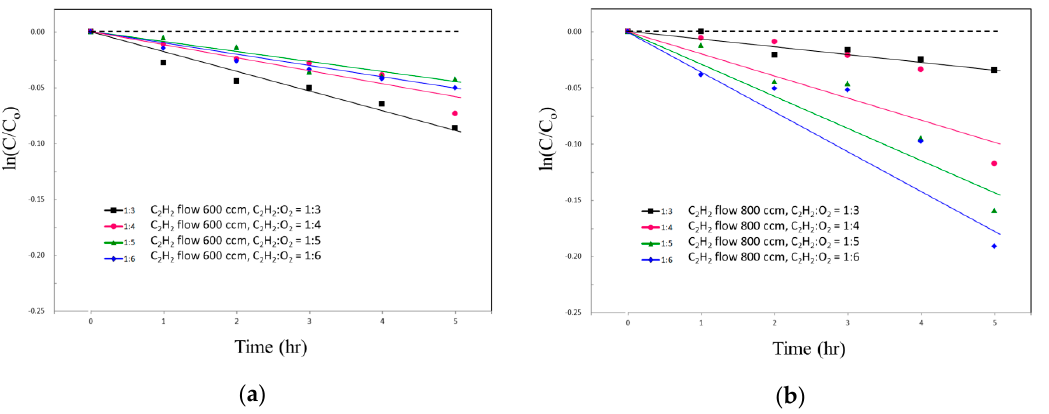
Figure 6. The degradation of methylene blue by TiO 2 powders under visible light for powder produced with ( a ) C 2 H 2 600 sccm and with ( b ) C 2 H 2 800 sccm. The dashed lines represent the degradation of methylene without the presence of TiO 2